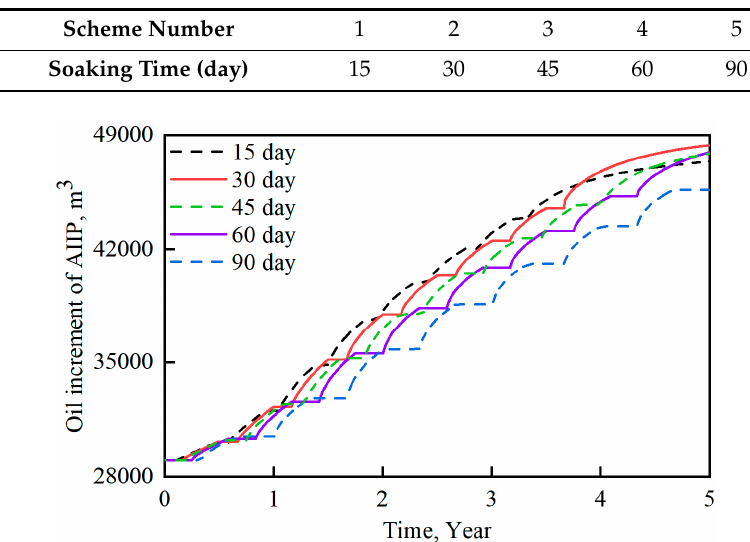
Table 10. Soaking time in di ff erent schemes.